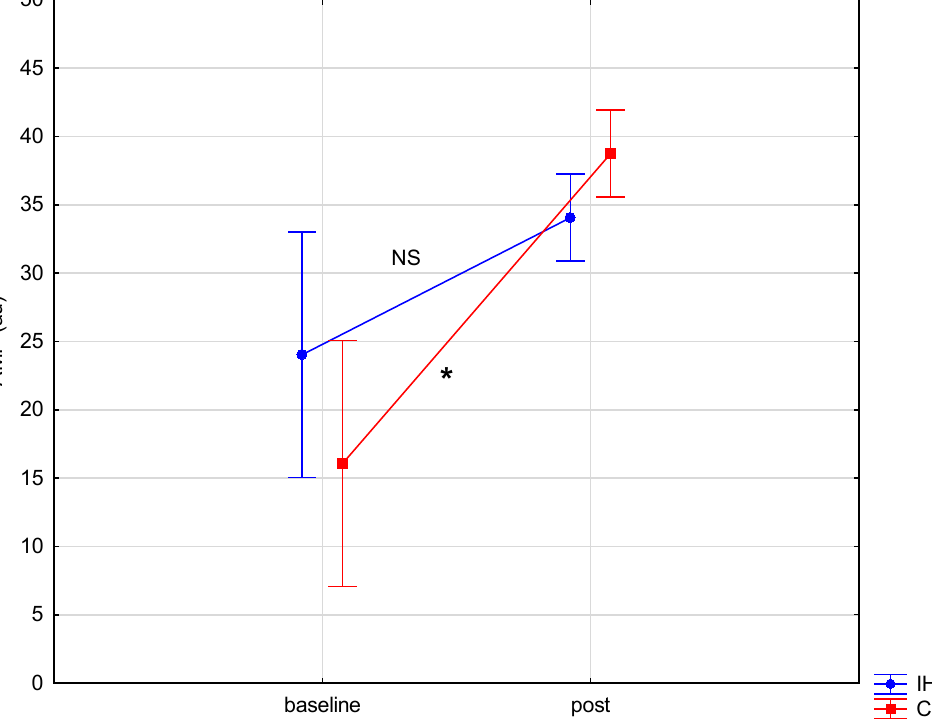
Figure 4. Red blood cell aggregation amplitude (AMP) in rowers training in the hypoxia (intermittent hypoxic training, IHT) and normoxia (control, CON) conditions before and after the intervention (*: p < 0.05, NS: non-significant).